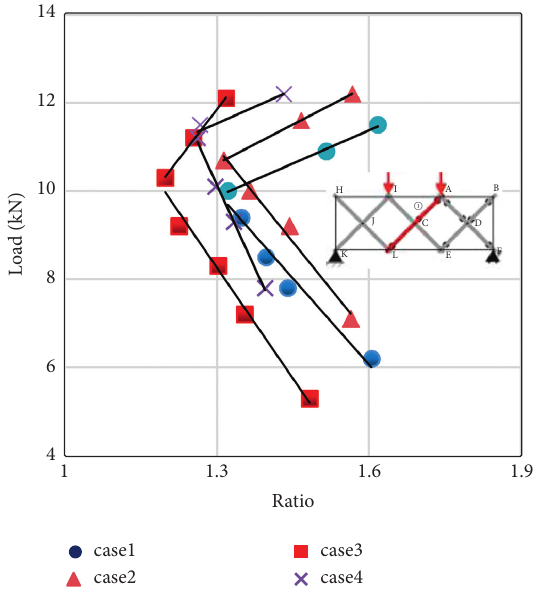
Figure 11: Ratio curves of the bending strain and axial strain of bar 1 in cable-strengthened structure.